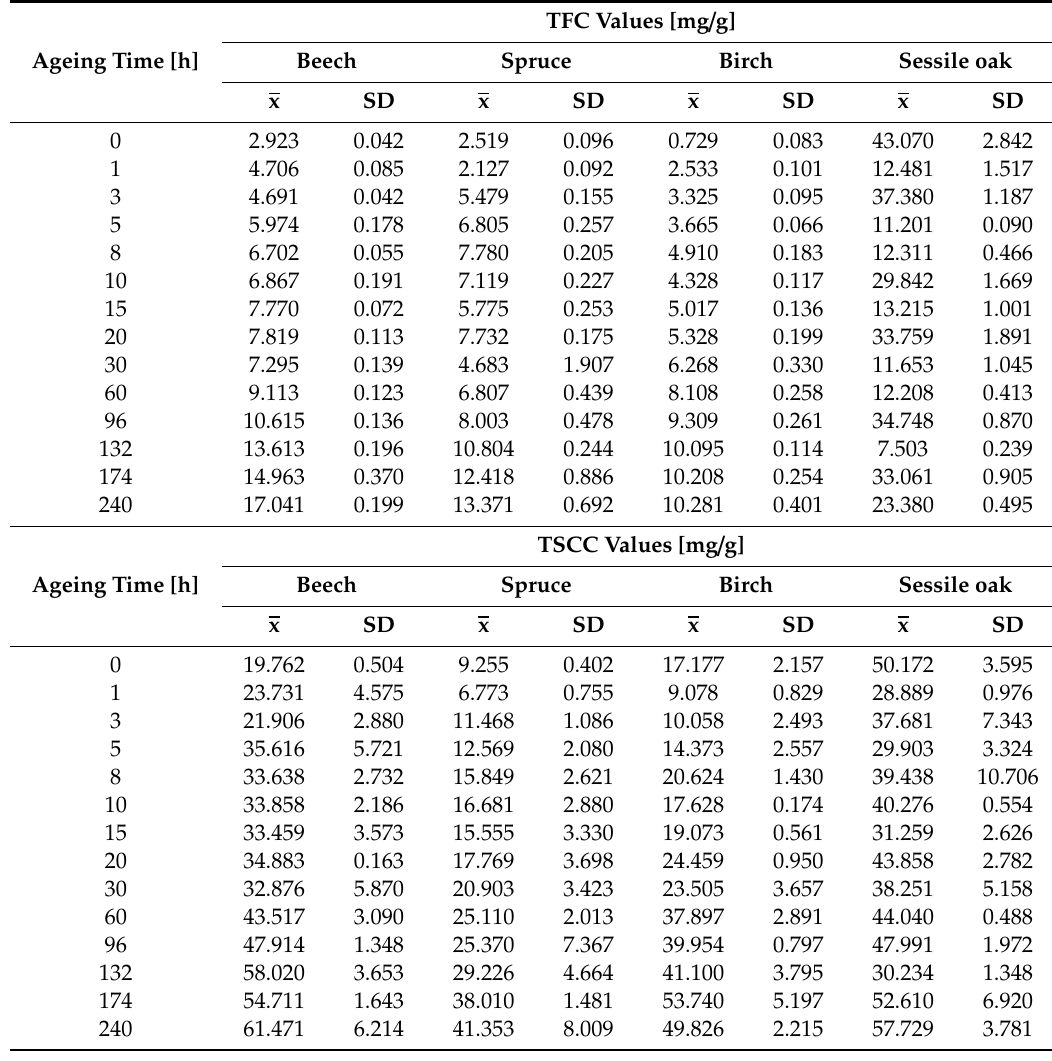
Table 3. The average values of TPC and TSCC and its